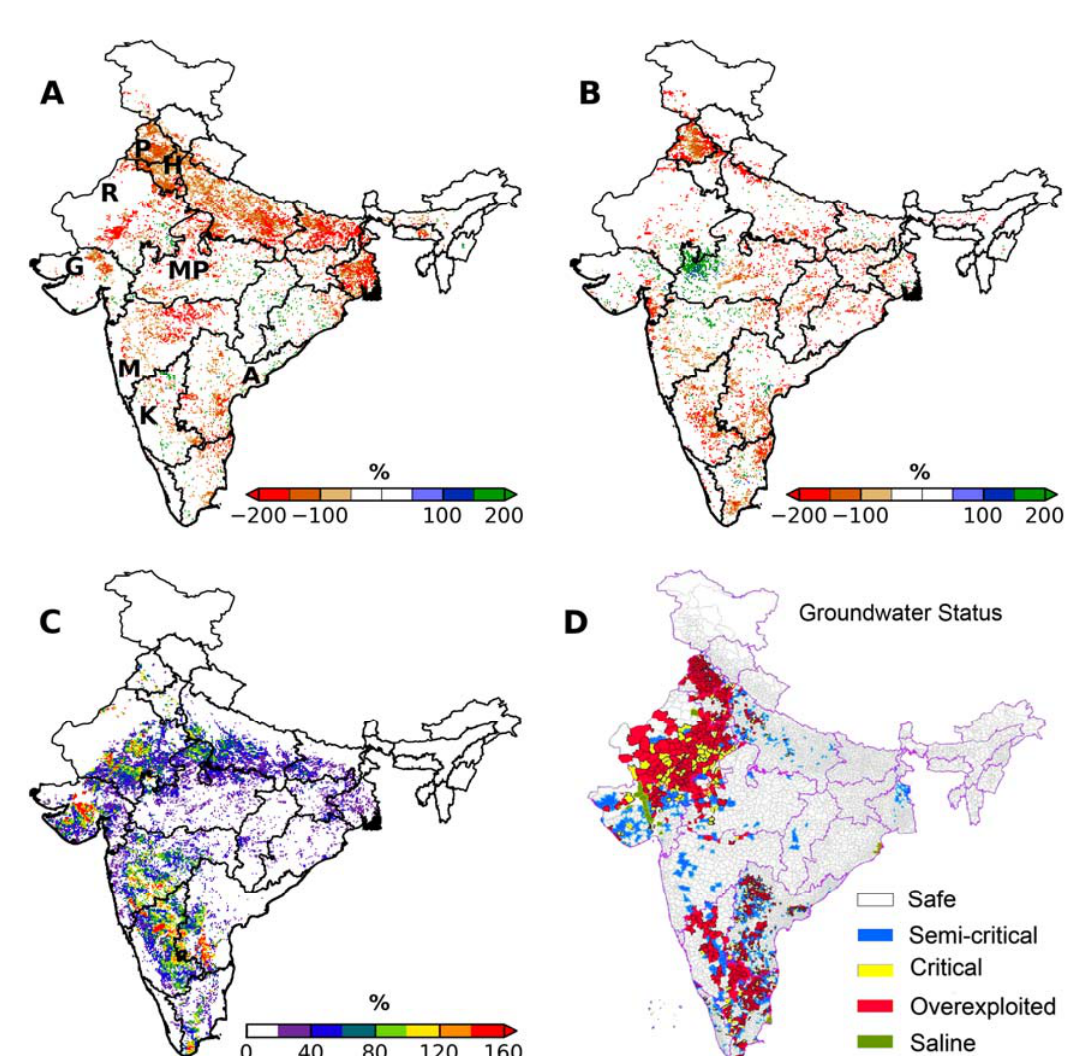
Figure 6. Geographical distribution of the change in growth rate (%) of (A) rabi and (B) kharif iNDVI for the decade (1996/97 to 2005/06) compared to the decade (1982/83 to 1991/92). Land use and crop statistics [31] report recent decreases in wheat area over the portions with sharpest declines in rabi iNDVI growth rate in the states of Punjab (P), Haryana (H) and Rajasthan (R), and decreases in irrigated area in the states of Maharashtra (M), Karnataka (K), and Andhra Pradesh (A). Increasing rates of iNDVI are observed during the kharif season in Madhya Pradesh (MP) in proximity of the Gandhi Sagar Dam. (C) amount of water needed to support the observed greening during the rabi season in the period 1982/83 to 2005/06, expressed as % mean annual rainfall (see Data and Methods ). The states of Punjab and Haryana do not show change in water requirements because here the greening preceded the satellite record of vegetation greenness. (D) Status of groundwater exploitation by geographic block in India as of March 2004